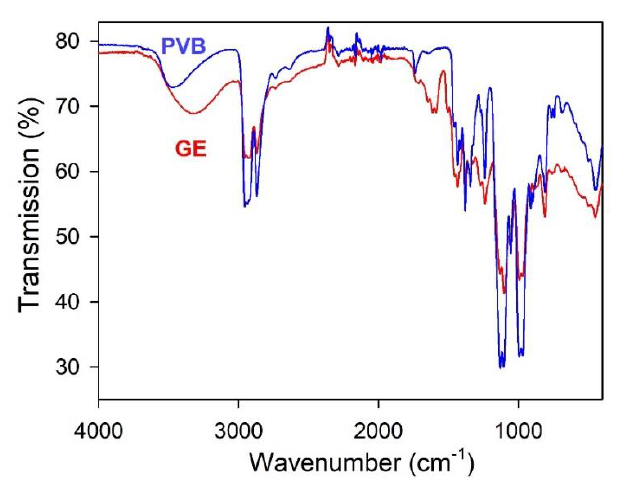
Figure 2. FTIR spectra of poly(vinyl butyral) (PVB) and GE polymer.